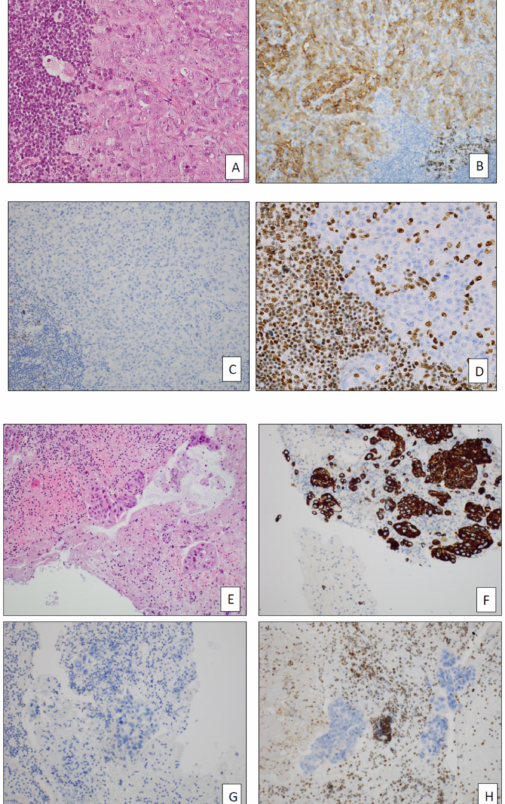
Figure 1. SMARCA4 -mutated lung carcinoma. Tissue ( A – D ) and cytological ( E – H ) samples from the same patient. ( A – D ) Transthoracic core biopsy. ( A ) Proliferation of a poorly differentiated carcinoma (hematoxylin eosin, magnification × 200). ( B ) Expression of cytokeratins (anti-pancytokeratins antibody, immunoperoxidase, magnification × 200). ( C ) Absence of TTF1 expression on tumor cells (anti-TTF1 antibody, immunoperoxidase, magnification × 200). ( D ) Tumor showing an absence of BRG1 expression on tumor cells but with a strong expression of BRG1 on lymphocytes (anti- BRG1, ab4081 clone, immunoperoxidase, magnification × 200). ( E – H ) Endobronchial ultrasound (EBUS)-guided transbronchial needle aspiration. ( E ) Different size of tumor cell nests without differentiation (hematoxylin eosin, magnification × 200). ( F ) Strong expression of cytokeratins (anti- cytokeratin 7 antibody, immunoperoxidase, magnification × 200). ( G ) Absence of TTF1 nuclear staining in tumor cells (anti-TTF1 antibody, immunoperoxidase, magnification × 200). ( H ) Absence of BRG1 staining in nuclei tumor cells associated with BRG1 expression in lymphocytes (ab4081 clone, immunoperoxidase, magnification ×